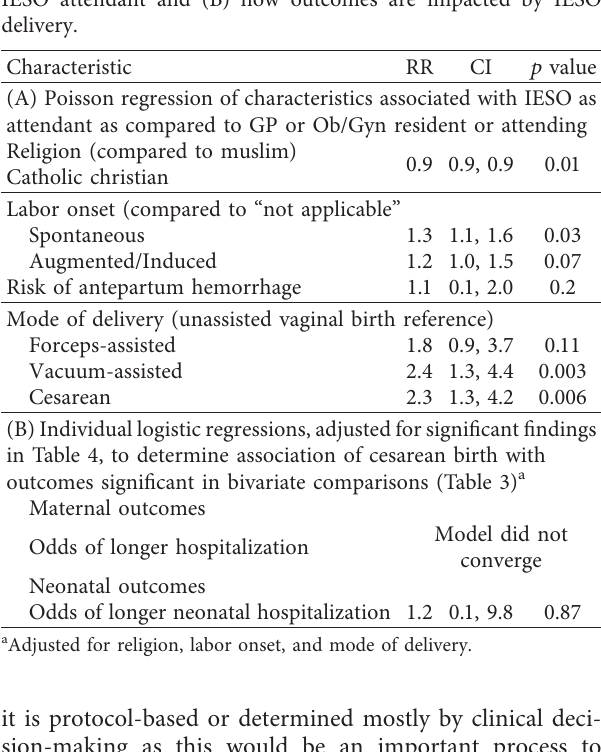
Table 4: (A) Multivariable model of characteristics associated with IESO attendant and (B) how outcomes are impacted by IESO delivery.